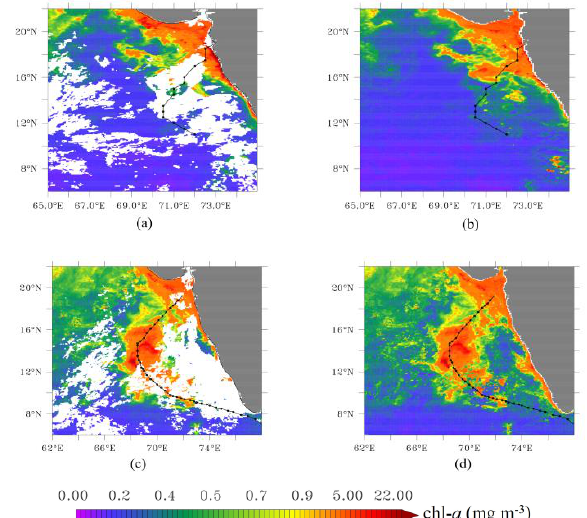
Figure 2. (a) The spatial coverage of chl- a (a) and (c) before (b) and (d) after reconstruction Phyan and Ockhi cyclone. The black line in the image is the cyclone track.